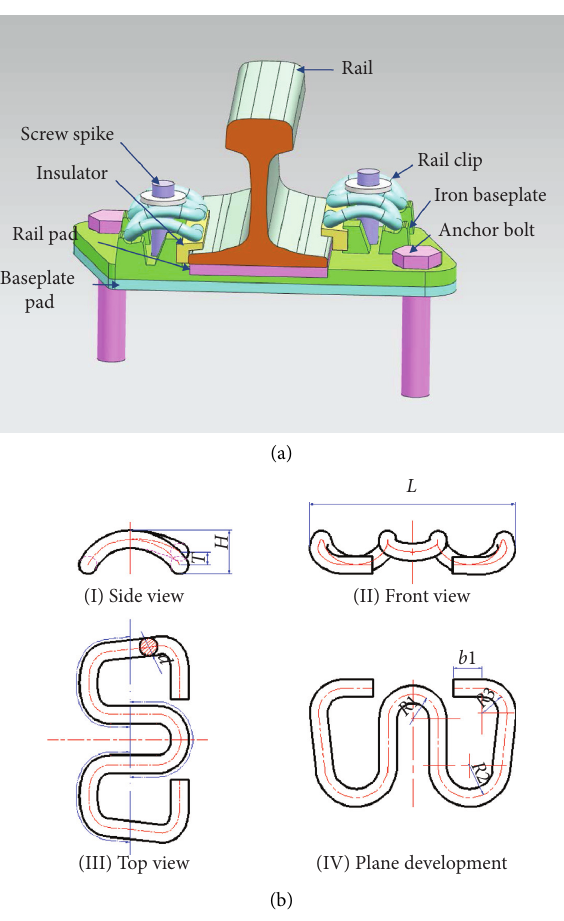
Figure 1: Schematic diagram of the novel fastener system: (a) assembly drawing for fasteners; (b) two-dimensional plan for the elastic rail